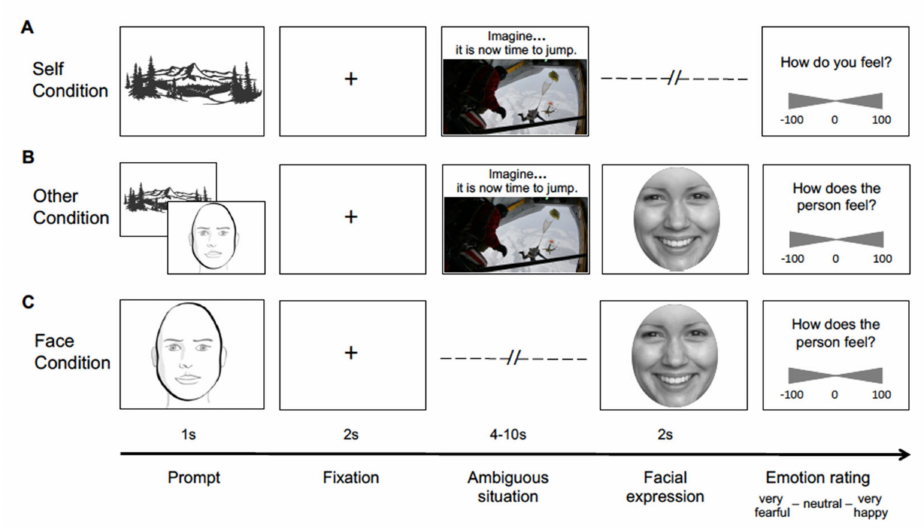
Figure 1. Example stimuli of the SOFE task. Participants were instructed to first imagine themselves in a happy or fearful situation and to either rate their own experienced emotion (Self condition, A ) or the emotional expression displayed by another person being in the same situation (Other condition, B ). In the Face condition ( C ), participants were asked to rate the same facial emotional expressions without a preceding situational stimulus. The two-sided continuous rating scale ranged from very fearful ( − 100) over neutral (0) to very happy (100). Conditions were introduced by brief image prompts.